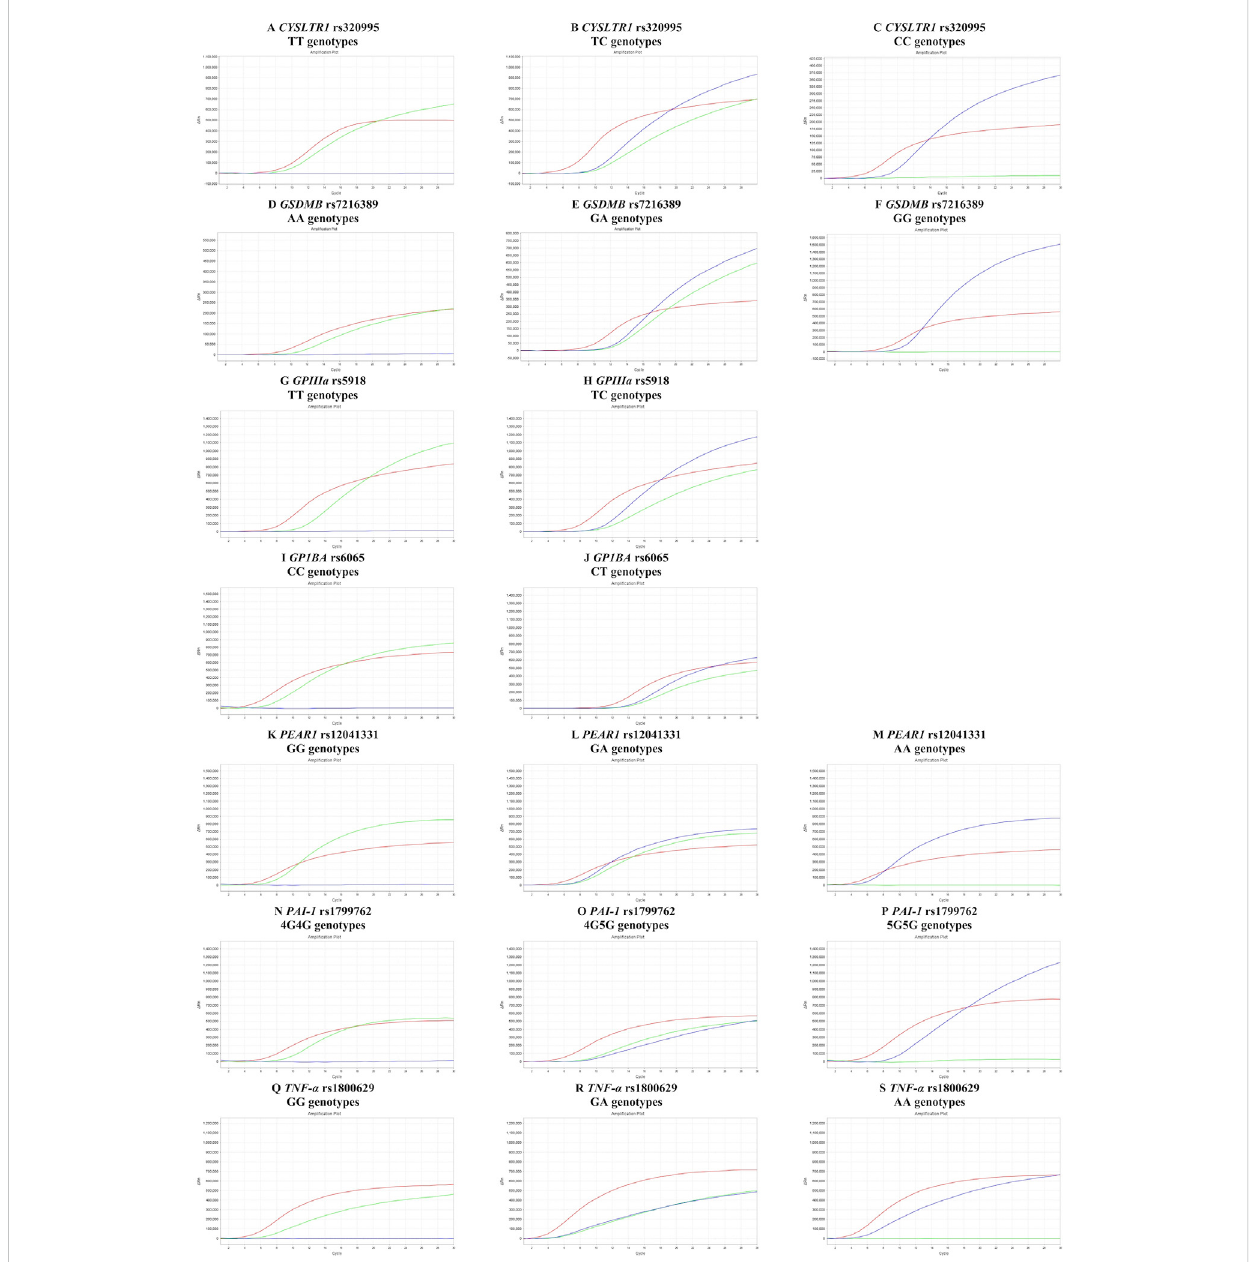
FIGURE 1 Ampli fi cation plots for genotypes of CYSLTR1 rs320995, GSDMB rs7216389, GPIIIa rs5918, GP1BA rs6065, PEAR1 rs12041331, PAI-1 rs1799762 and TNF- α rs1800629. (A – C) ampli fi cationplotsof CYSLTR1 rs320995TT,TCandCCgenotypesinfemale. (D – F) ampli fi cationplotsof GSDMB rs7216389AA, GA, and GG genotypes. (G,H) ampli fi cation plots of GPIIIa rs5918 TT and TC genotypes. (I,J) ampli fi cation plots of GP1BA rs6065 CC and CT genotypes. (K – M) ampli fi cation plots of PEAR1 rs12041331 GG, GA and AA genotypes. (N – P) ampli fi cation plots of PAI-1 rs1799762 4G4G, 4G5G, and 5G5G genotypes. (Q – S) Ampli fi cation plots of TNF- α rs1800629 GG, GA and AA